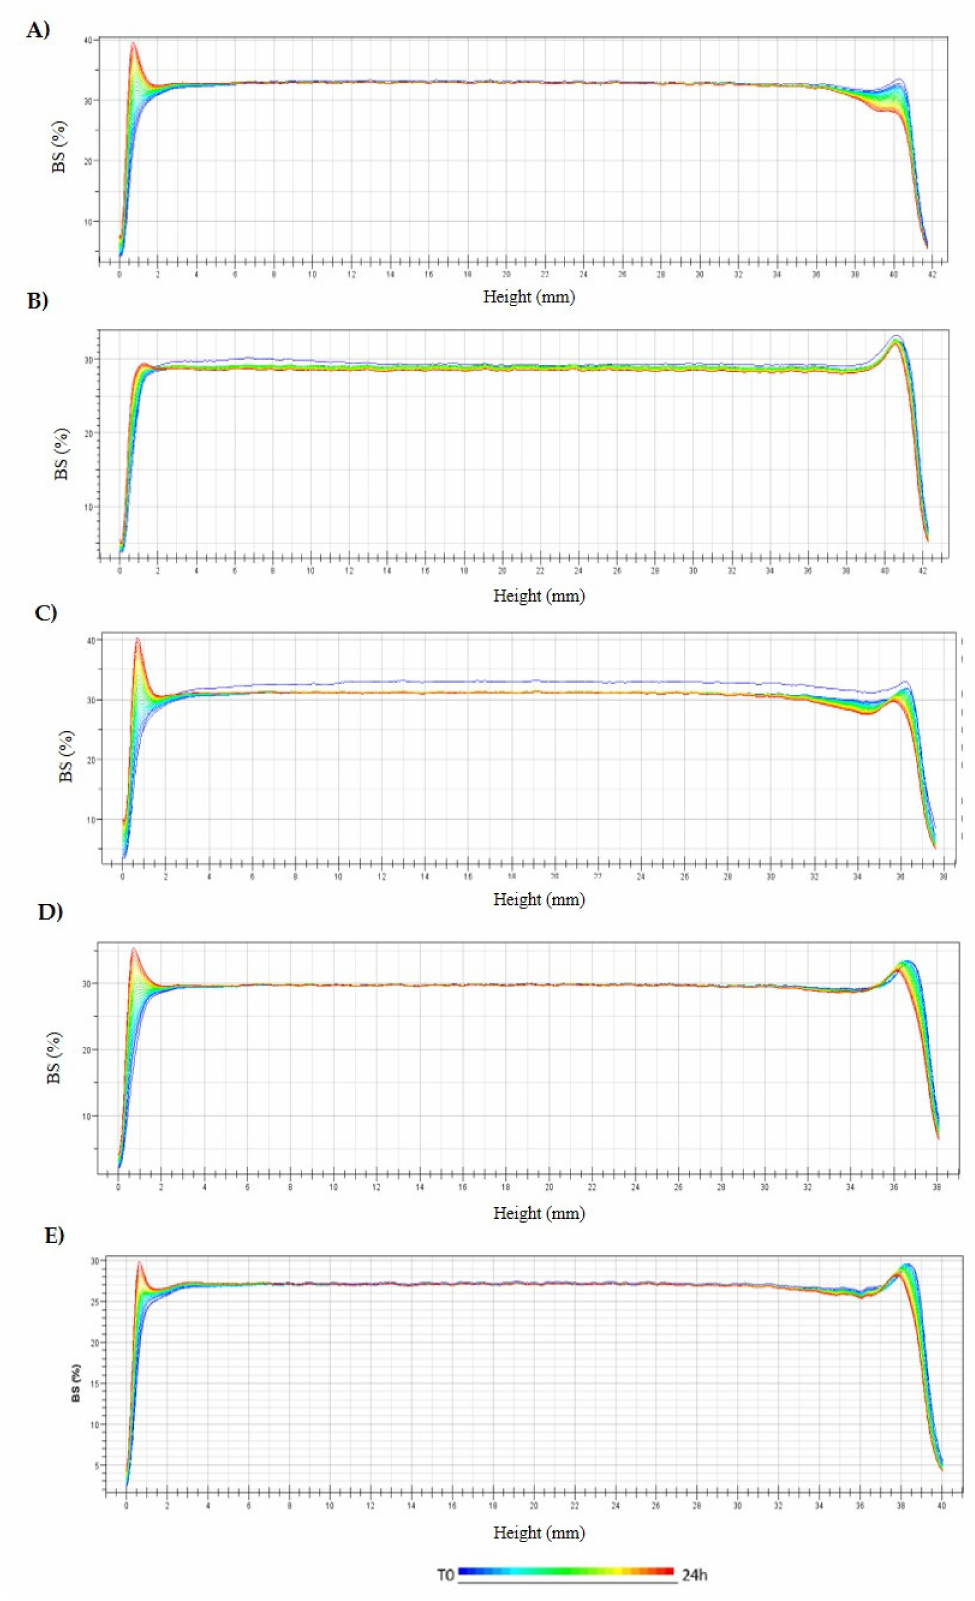
Figure 2. Backscattering profile of NPs measured monthly for 6 months after storage at 4 ◦ C. ( A ) TH-NP-L-, ( B ) TH-NP-P-, ( C ) TH-NP-P-C+, ( D ) TH-NP-PP- and ( E )